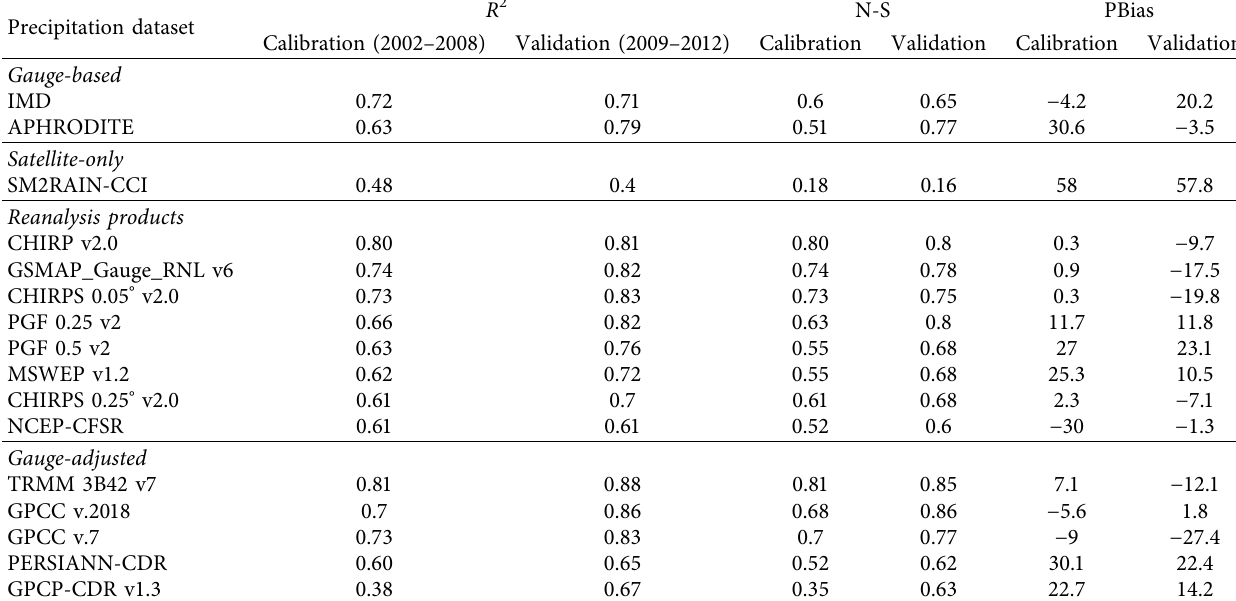
Table 4: Statistical coefficient values for monthly